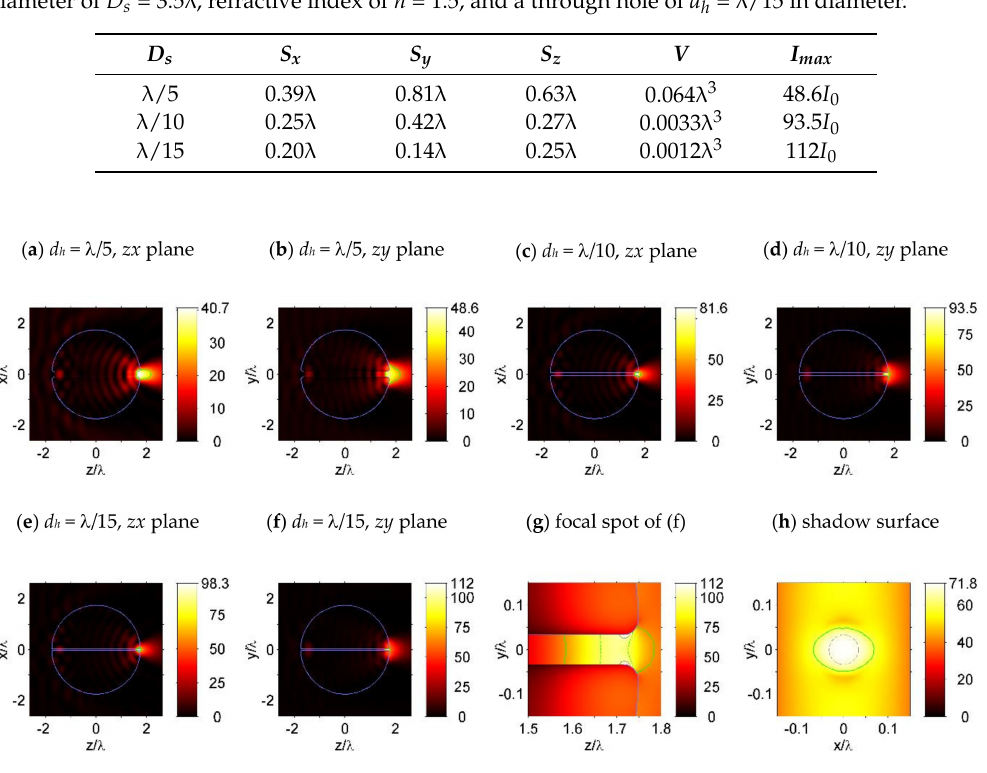
Figure 3. Light intensity (|E| 2 ) of the simulated dielectric microspheres with a nanohole of size ( a , b ) d h = λ /5, ( c , d ) d h = λ /10, and ( e – h ) d h = λ /15. The sphere diameter and refractive index are set as D s = 3.5 λ and n = 1.5. Features of the focal spot in ( f ) are plotted in ( g ), where the green solid lines, the gray dashed lines, and the gray solid lines indicate the contour lines at values 0.5 I max , 0.8 I max , and 0.9 I max , respectively. For a sphere with a hole size of d h = λ /15, light intensity along a plane that is 0.001 λ from the shadow surface is plotted in ( h ), with a circle plotted in gray dashed lines, indicating the projection of the hole